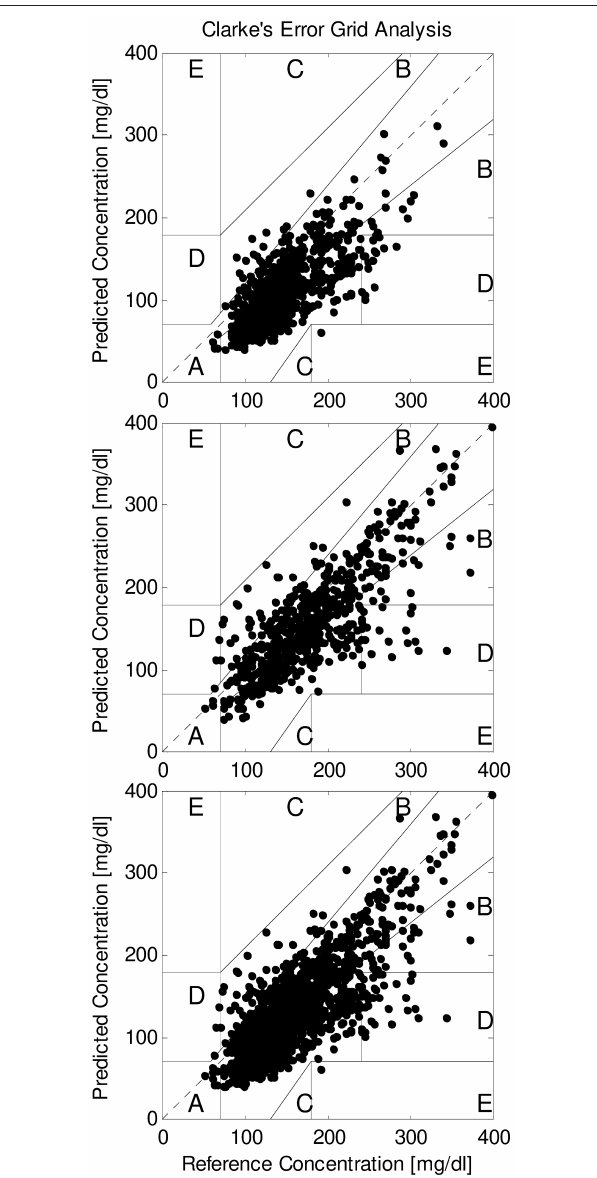
FIGURE 1 | Clarke error grid analysis of SMBG and FGM readings (reference and predicted, respectively) in all patients grouped, for readings during hemodialysis sessions (upper panel), during interdialytic periods (only T2DM patients; intermediate panel), and for all readings grouped (lower panel).